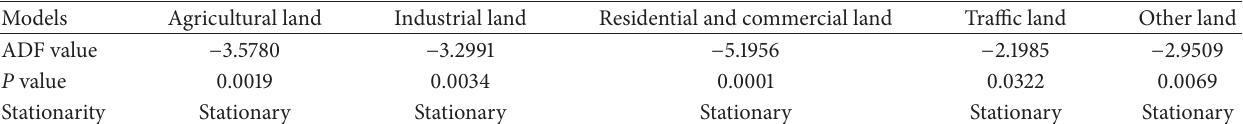
Table 9: Stationarity test results for the residual series in the regression models.